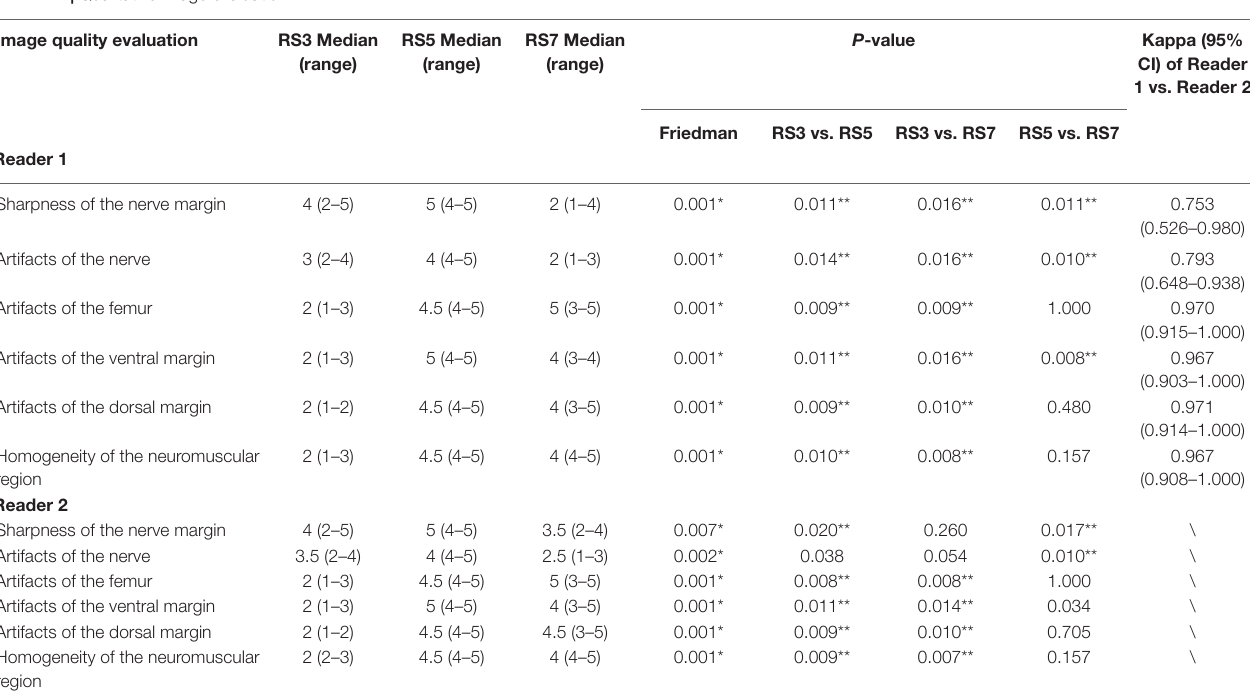
TABLE 2 | Qualitative image